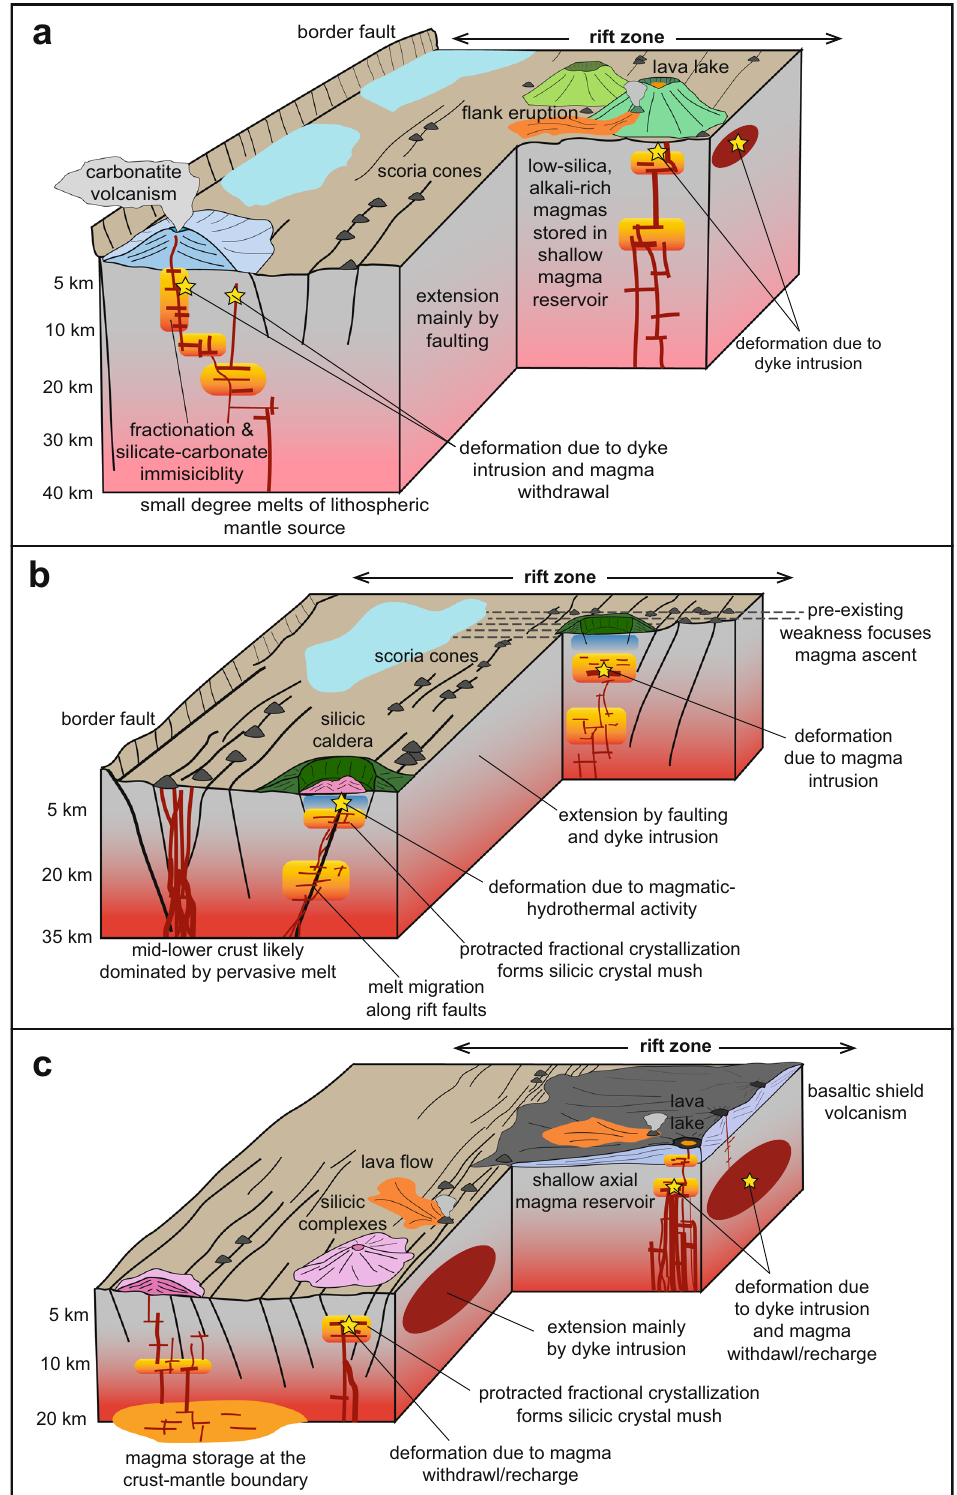
Fig. 3 Conceptual model of magmatic systems in rifts at different stages of their evolution. a Early-stage rifting, based on Ol Doinyo Lengai and the Natron Rift in Tanzania (foreground), and the Virunga volcanoes on the western branch of the EARS (background). b Mature continental rifting, based on the Main Ethiopian Rift. c Nascent sea- fl oor spreading, based on Afar, Ethiopia, with the Manda Hararo Rift in the foreground, and the Erta Ale segment in the background. See text for